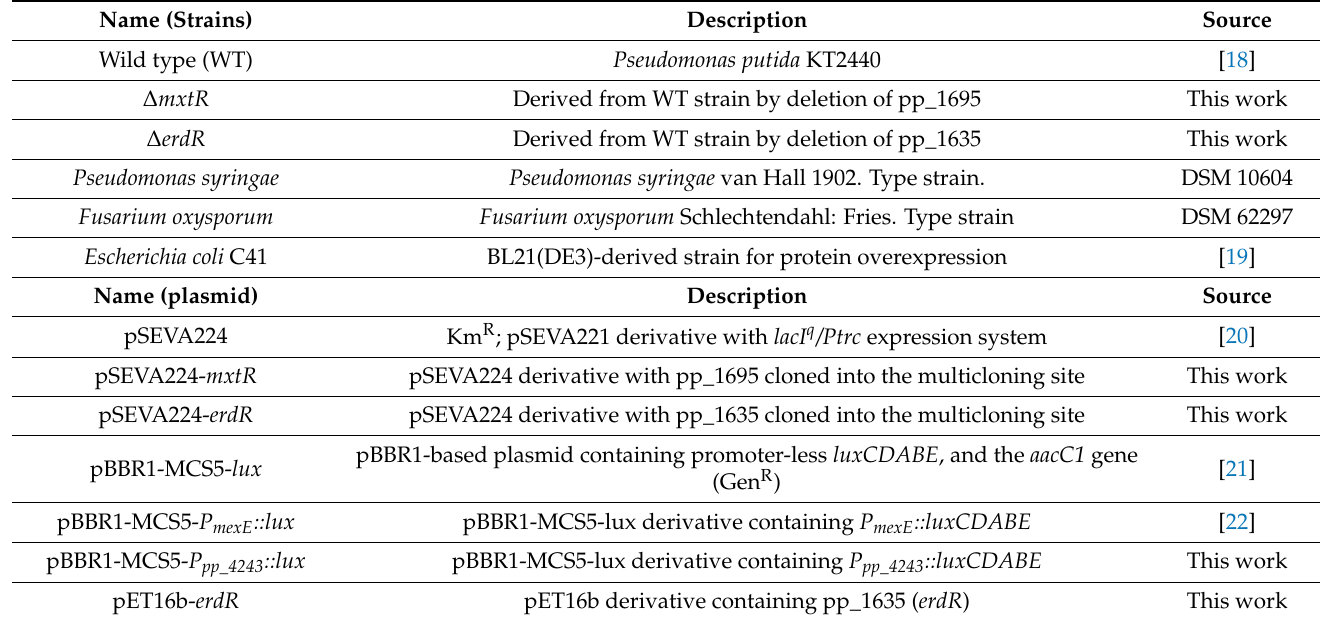
Table 1. List of strains and plasmids used in this